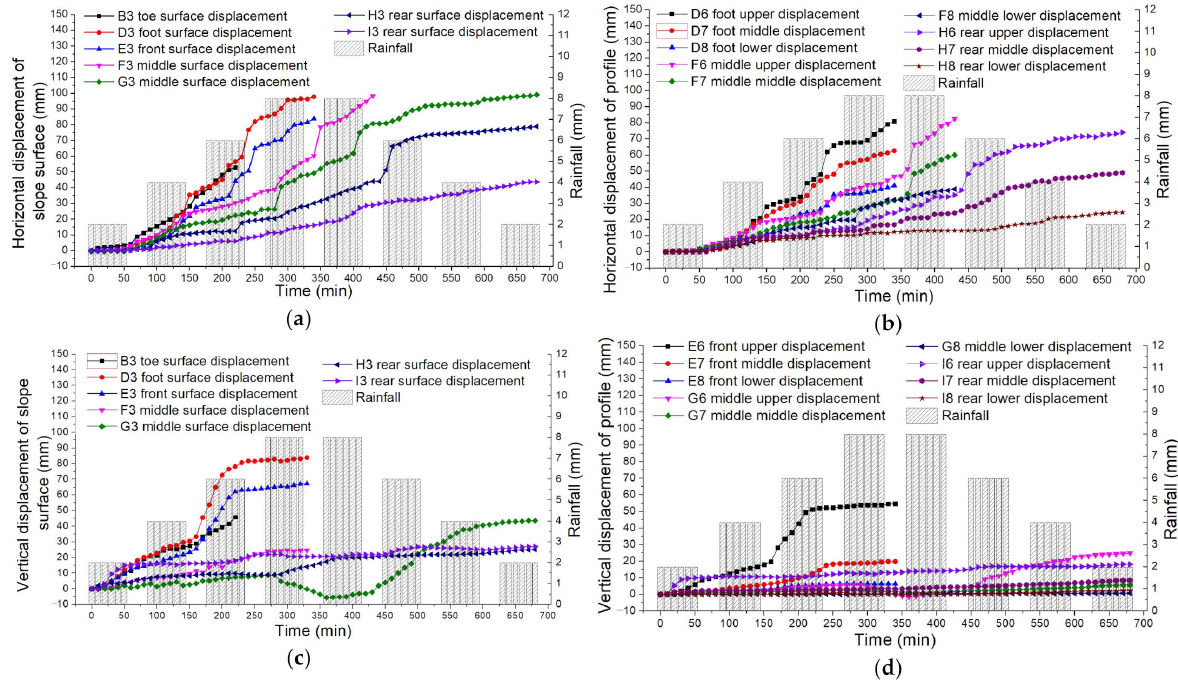
Figure 11. Slope displacement curve. ( a ) Horizontal displacement of slope surface, ( b ) Horizontal displacement of profile, ( c ) Vertical displacement of slope surface, ( d ) Vertical displacement of